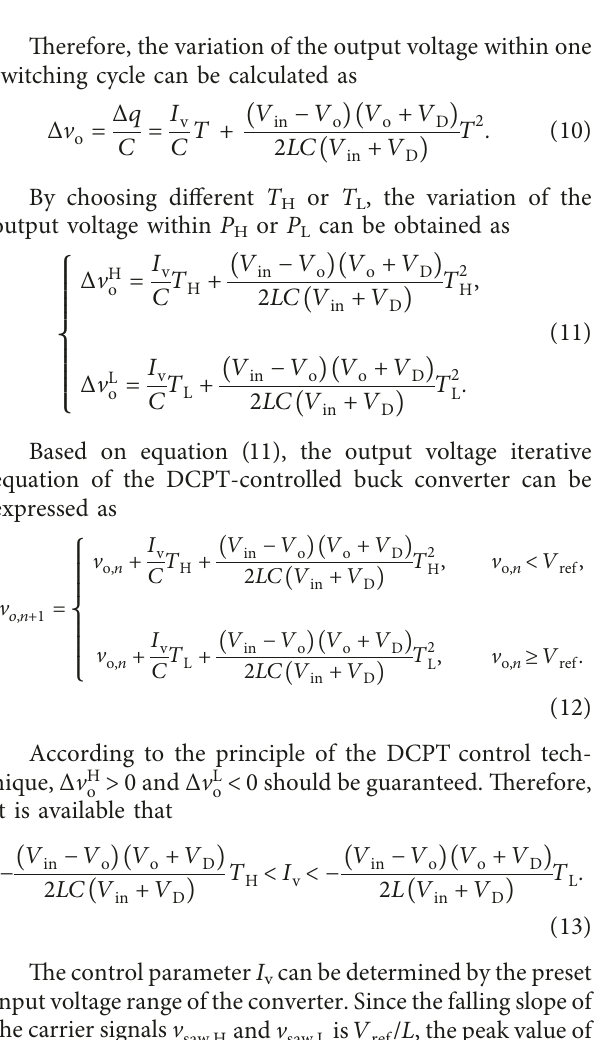
Figure 1: Working principle diagram of the DCPT-controlled buck converter. (a) Schematic diagram. (b) Working waveforms.